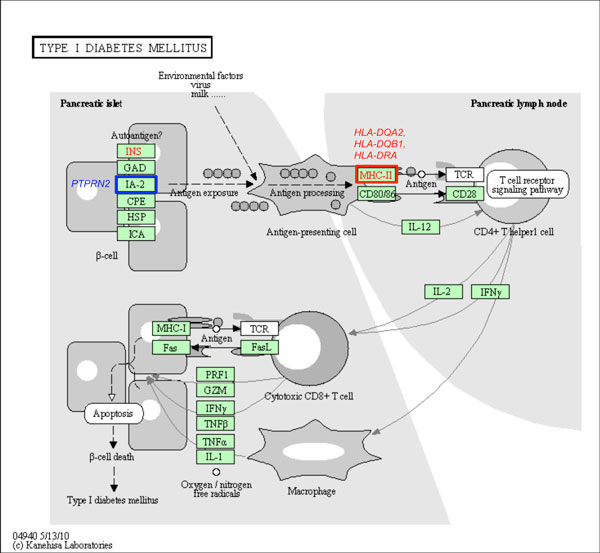
The iLOCi detected genes from T1D and their maps in 'type I diabetes mellitus' pathway. The KEGG pathway diagram [34] shows the mapping of T1D-associated genes identified among 1000 top ranked iLOCi pairs in the 'type I diabetes mellitus' KEGG pathway. The gene families containing the genes previously reported in HuGE Navigator database and the novel disease genes are highlighted in the red boxes and the blue boxes, respectively, with their associated gene names.